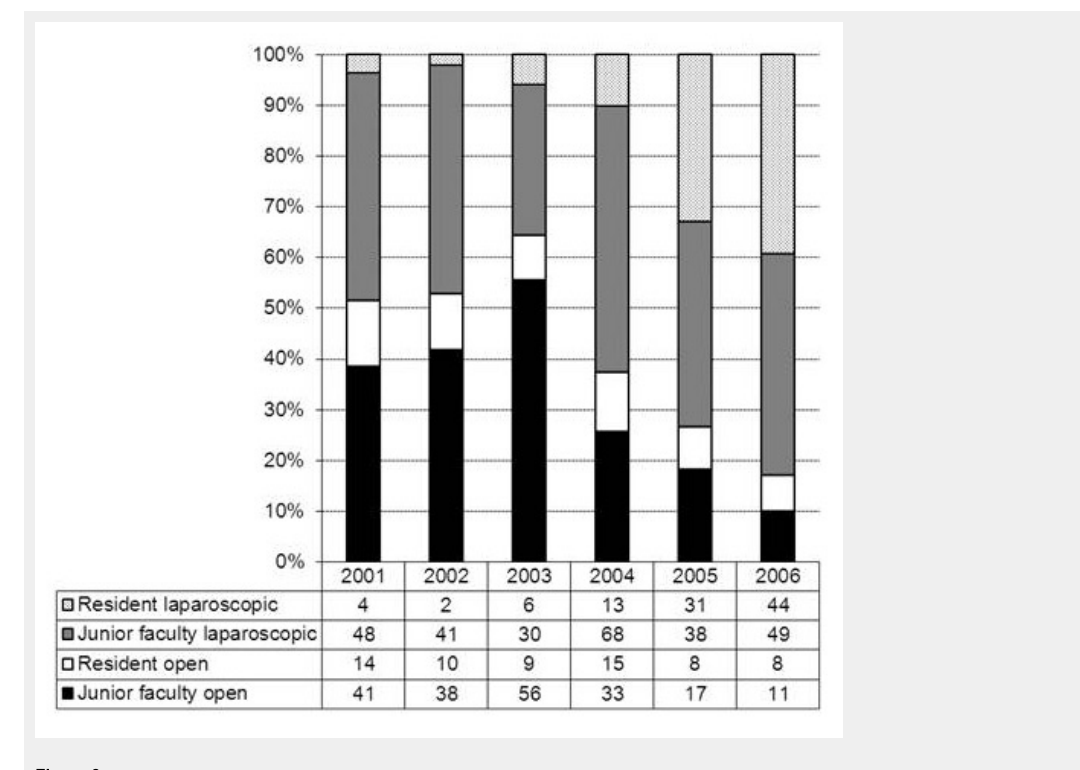
Figure 3 Percentage and absolute numbers of procedures by status of the surgeon (residents / junior faculty members).